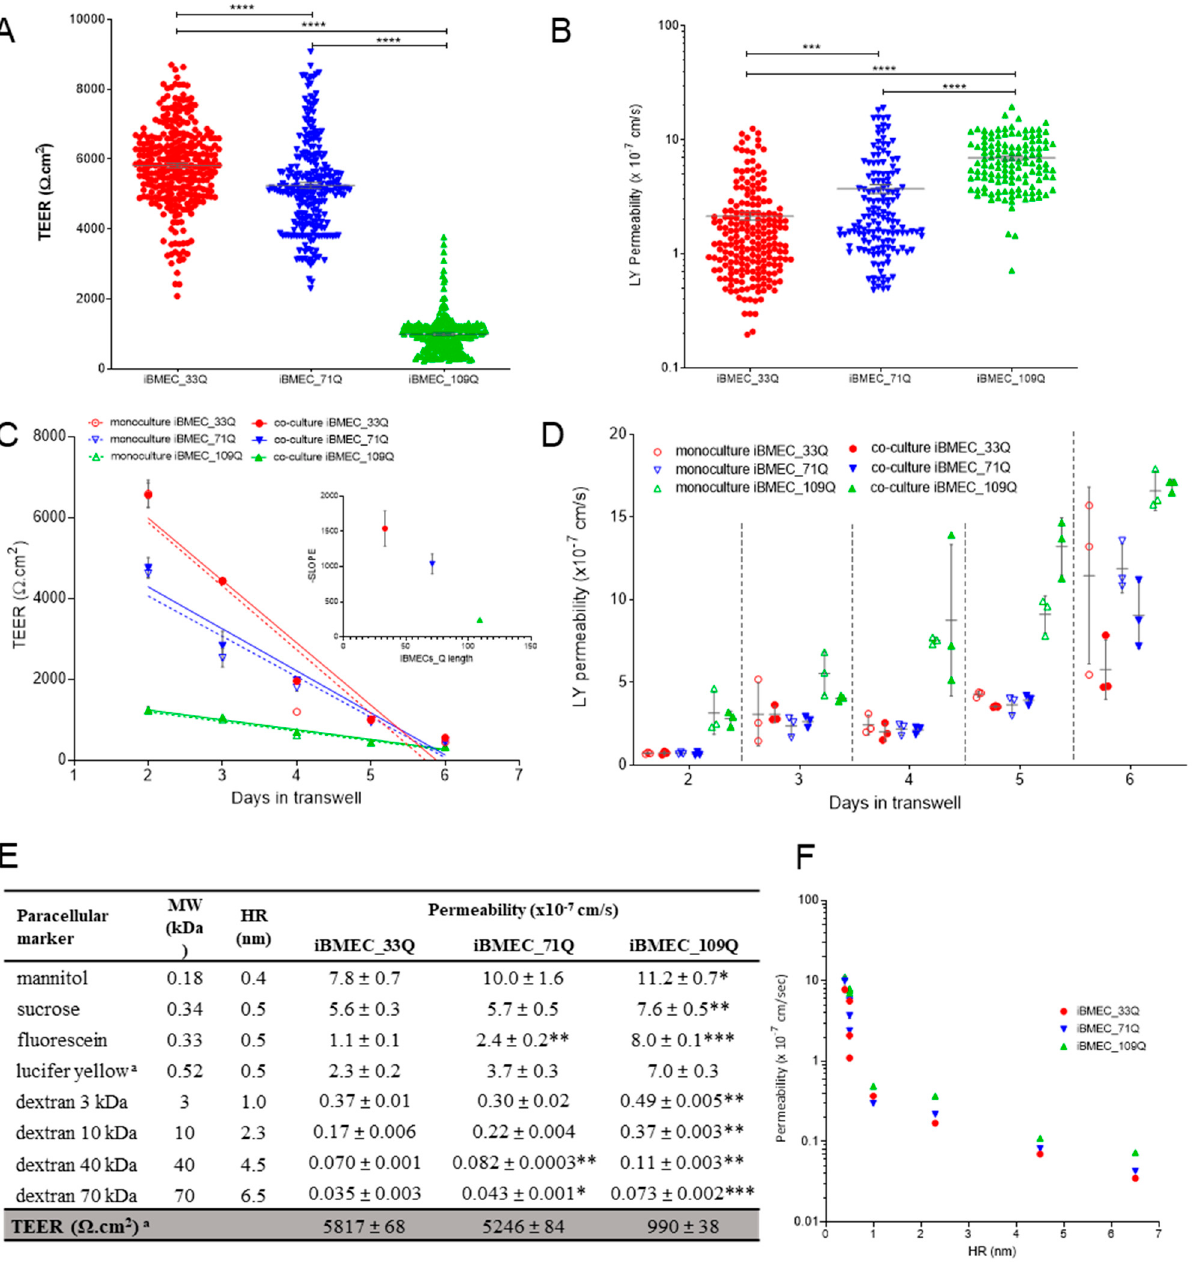
Figure 3. Barrier properties. ( A ) TEER measurements and ( B ) LY permeability at day 1 co-culture of independent samples, n > 100. Statistical analysis: two-way ANOVA followed by Bonferroni post hoc test, where *** p < 0.001 and **** p < 0.0001. ( C ) TEER as a function of time in mono- and co-culture with astrocytes and ( D ) corresponding LY permeability time-course in mono- and co-culture, n = 3. ( E ) Permeability in the BBB models of paracellular markers with different molecular weights (MW) and hydrodynamic radius (HR). Results are mean ± sd with n > 6 from at least two separated experiments. Statistical significance was analyzed by Student’s t -test against iBMEC_33Q: * p < 0.05; ** p < 0.01 and *** p < 0.001. a Statistics showed above ( A , B ). ( F ) Relationship of permeability and HR (nm) for paracellular markers listed in ( E ).